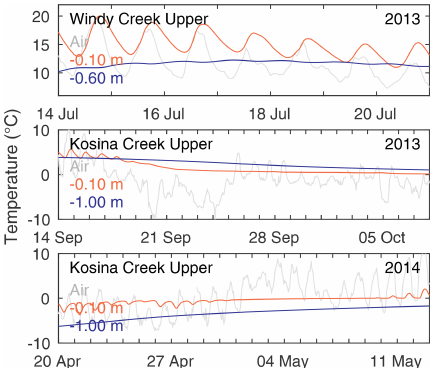
Figure 18. Hourly soil temperatures at depth below the soil sur- face illustrating three time periods: diurnal fluctuations in summer, soil freezing in fall, soil thaw in spring. Air temperature data are repeated from Fig. 9 for context. Each panel lists the depth of the soil temperature